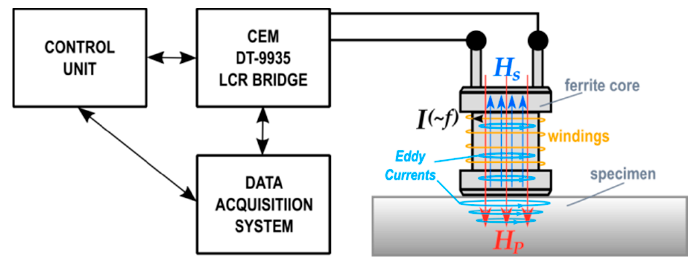
Figure 3. Measuring circuit diagram.